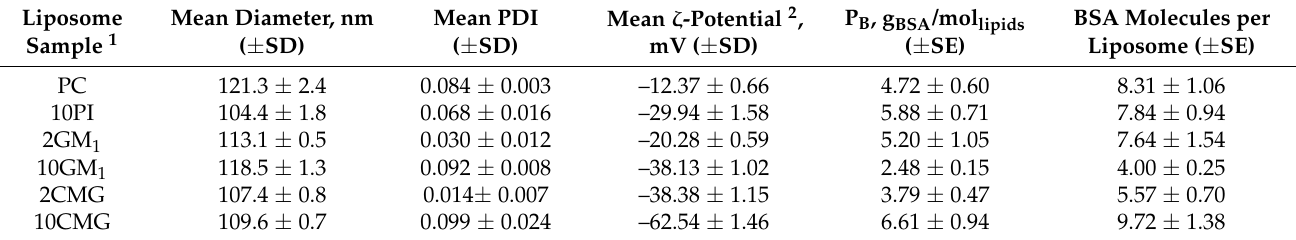
Table 1. Liposome characteristics.